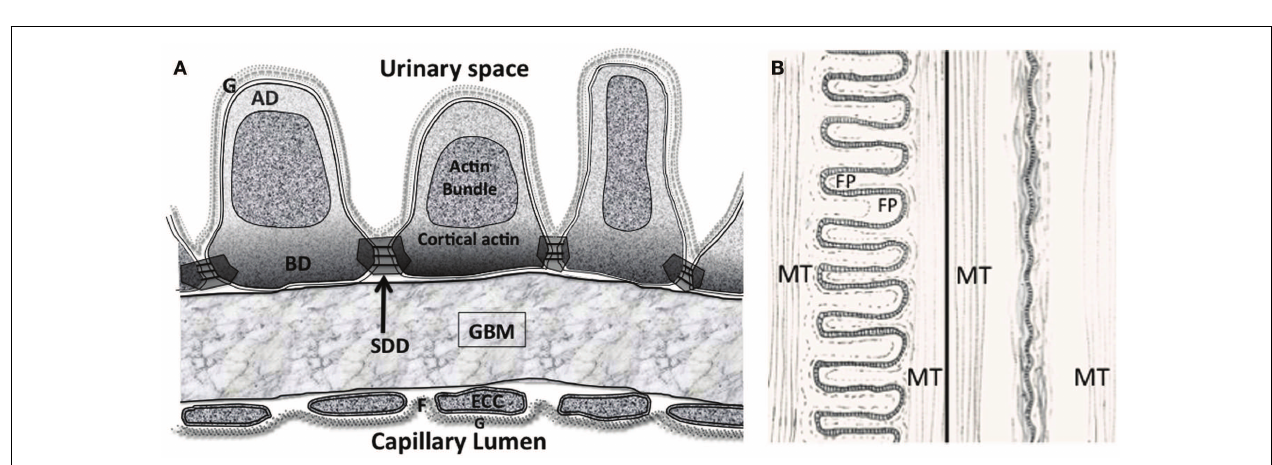
BD and SDD is thicker than AD. ECC, endothelial cell cytoplasm; F, fenestration; G, glycocalyx. (B) Interdigitating foot process (FP) pattern in health (left) and after effacement in disease (right).The dashed line in FP marks the boundary of the actin bundles. MT – microtubules in the major processes. Actin bundles and cortical actin either reduce to a diffuse band of actin after effacement or disperse with